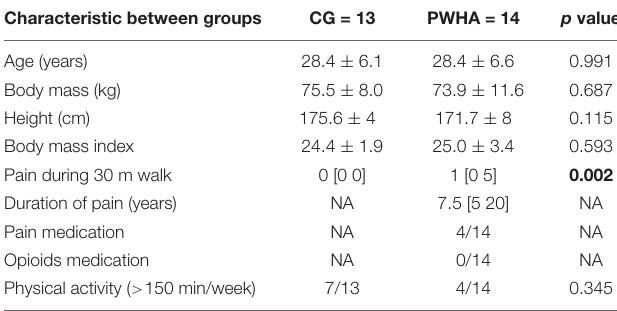
TABLE 1 | Clinical characteristics between